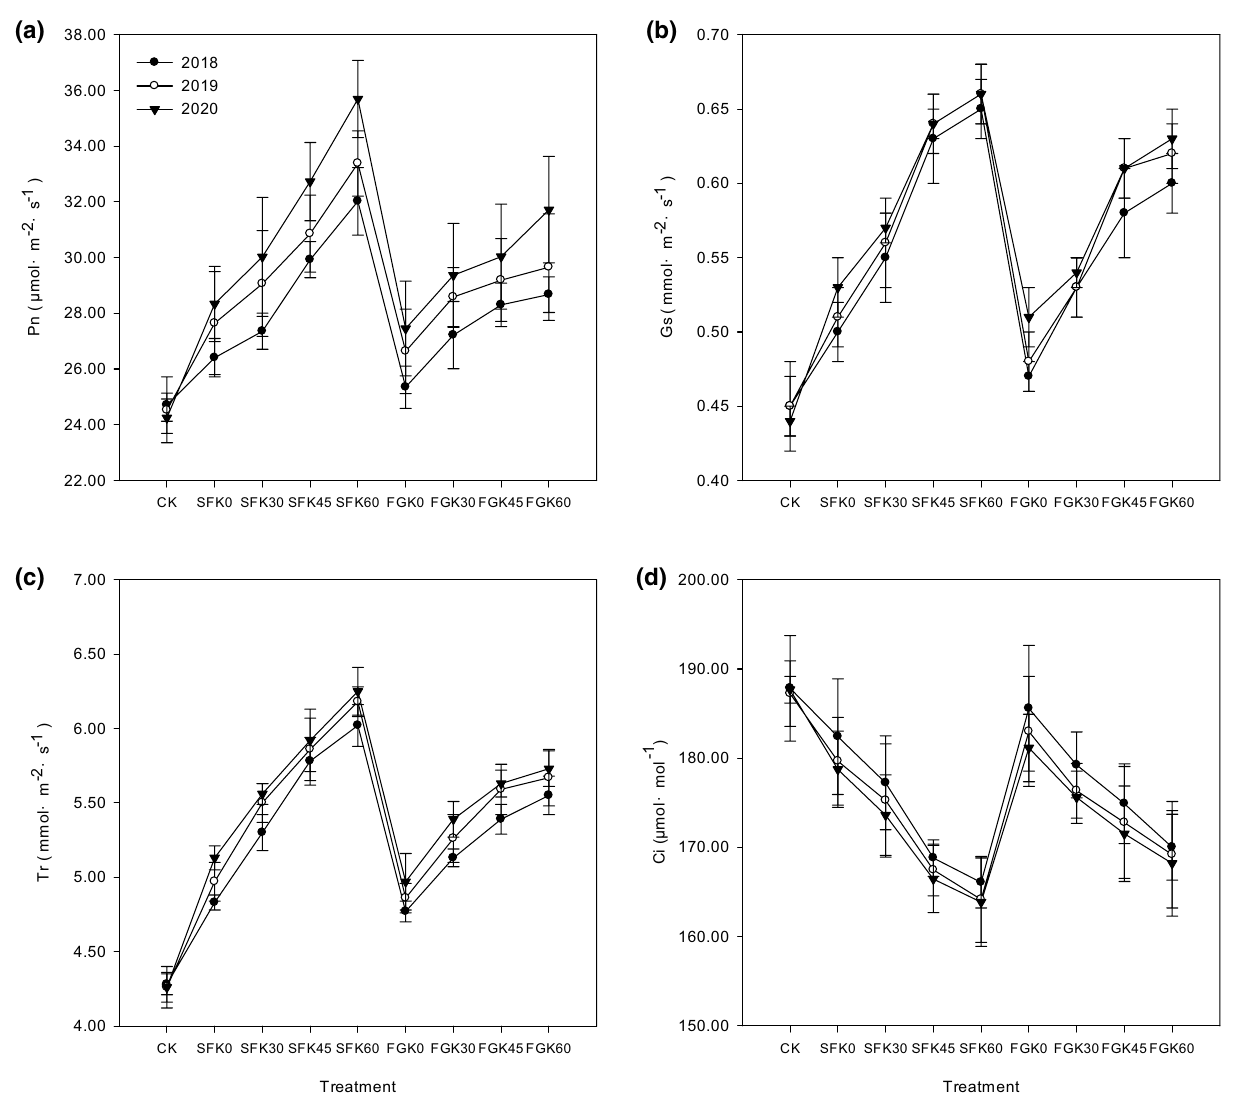
Figure 1. Effects of straw return methods and potassium fertilization levels on maize